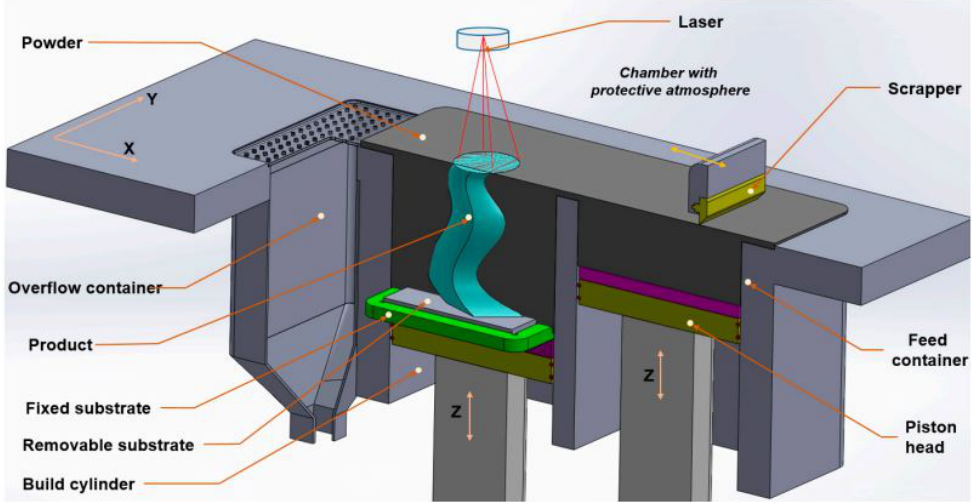
Figure 25. Schematic of selective laser melting 3D printing method. Reprinted with permission from Ref. [187]. Copyright 2017,